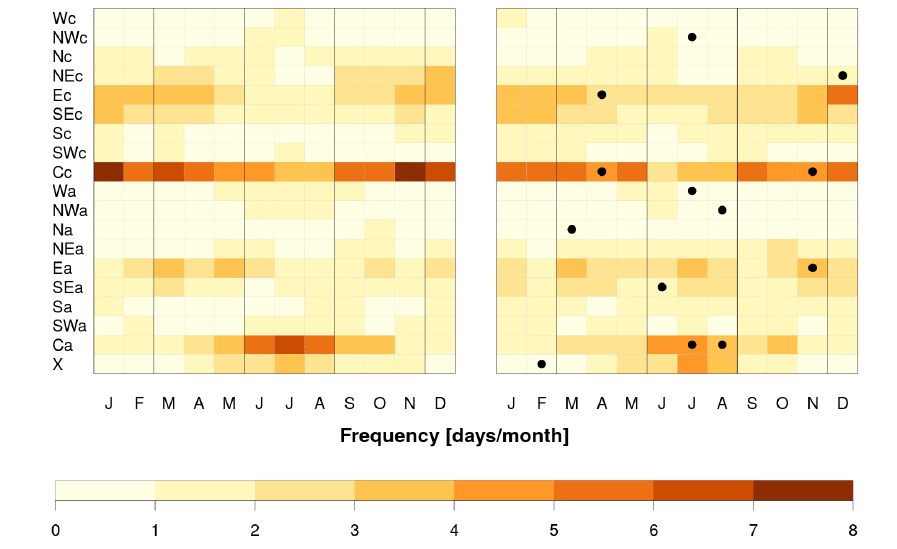
Figure 3. Mean monthly occurrence of weather types in ERA-Interim (1979–2008, left ) and the MPI-ESM-LR current climate simulation (1971–2000, right ), respectively. The dots mark statistically significant